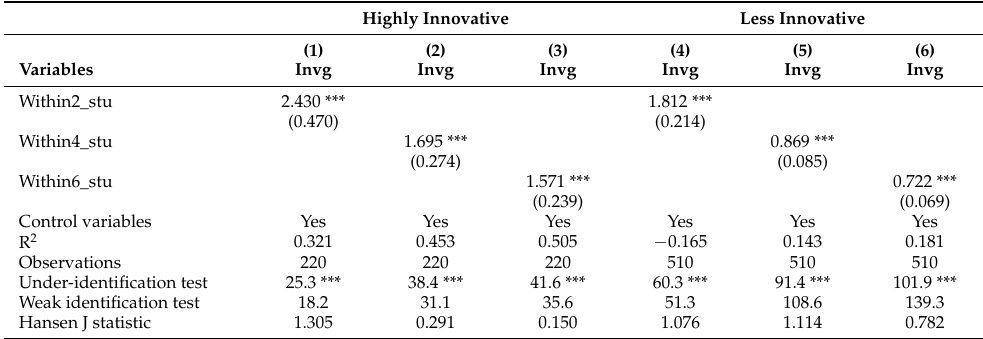
Table 5. The heterogeneous impact of city level on invention patents granted: university student ratio (top 30% as highly innovative cities).